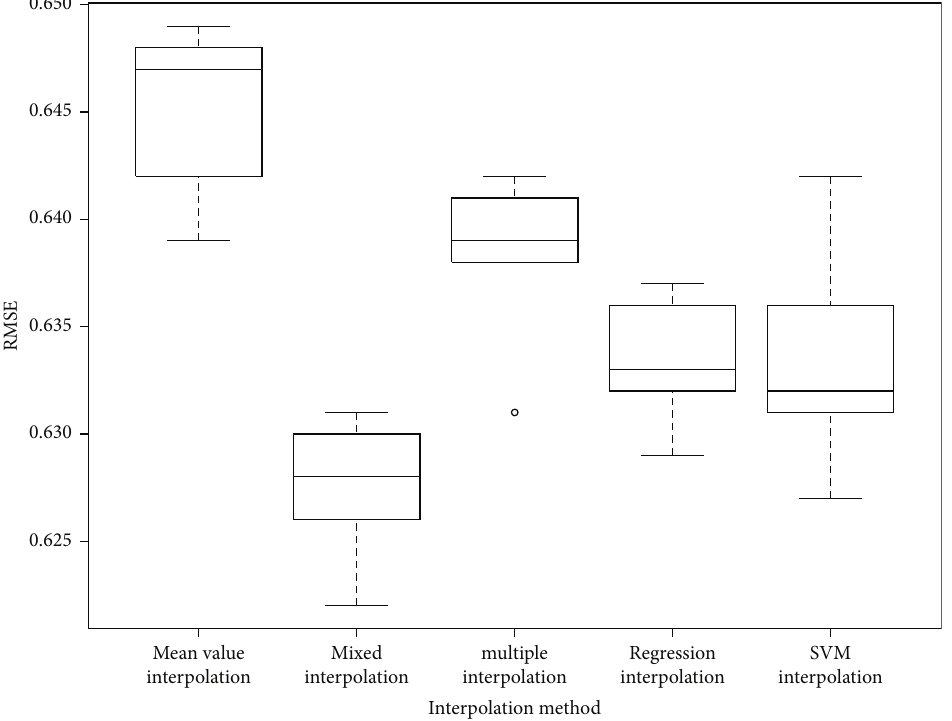
Figure 6: Boxplot of RMSE values of five interpolation methods under 5% data miss rate.